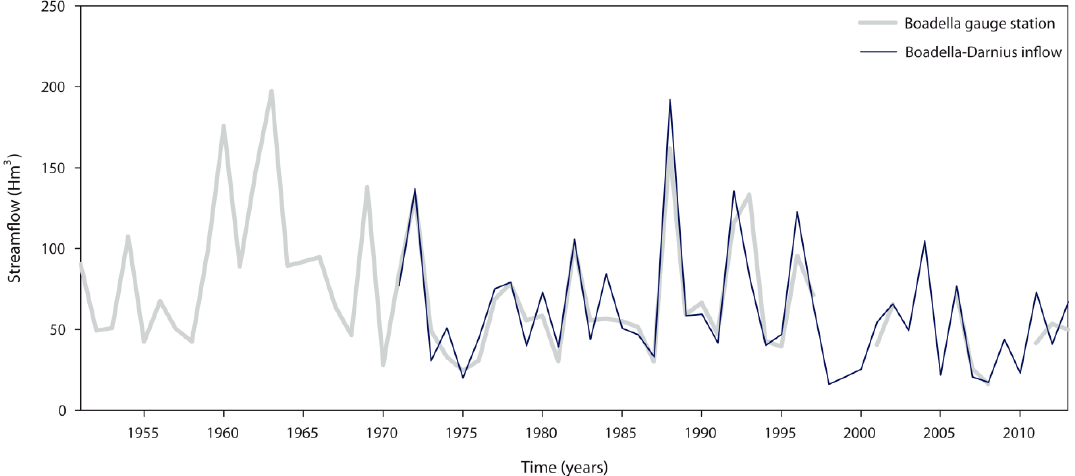
Figure 7. Observed annual streamflow at the Boadella gauge station (grey) and at the Boadella–Darnius dam inflow (blue). Table 4. Observed and simulated seasonally inflow variation under climate projection (RCP4.5) and